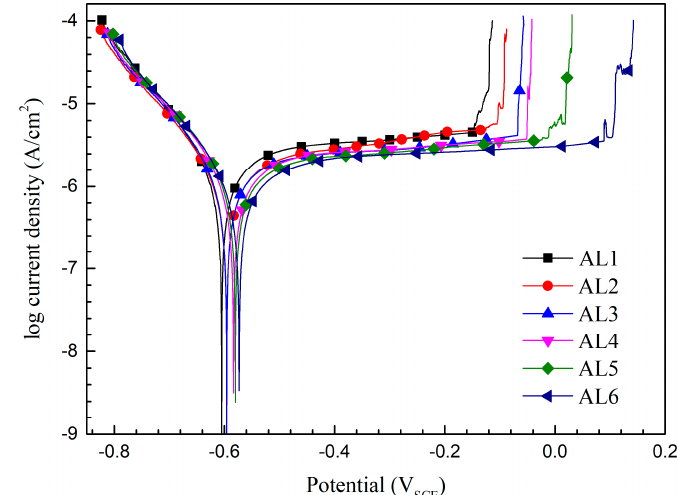
Figure 6. Typical potentiodynamic polarization curves of sintered 7075 alloys after 6 h immersion in 0.2 M Na 2 SO 4 + 0.01 M NaCl solution.